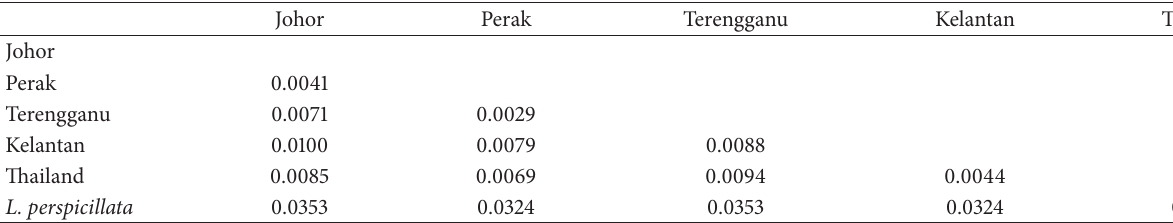
Table 3: Genetic distance analysis among populations for A. cinereus D-loop sequences.